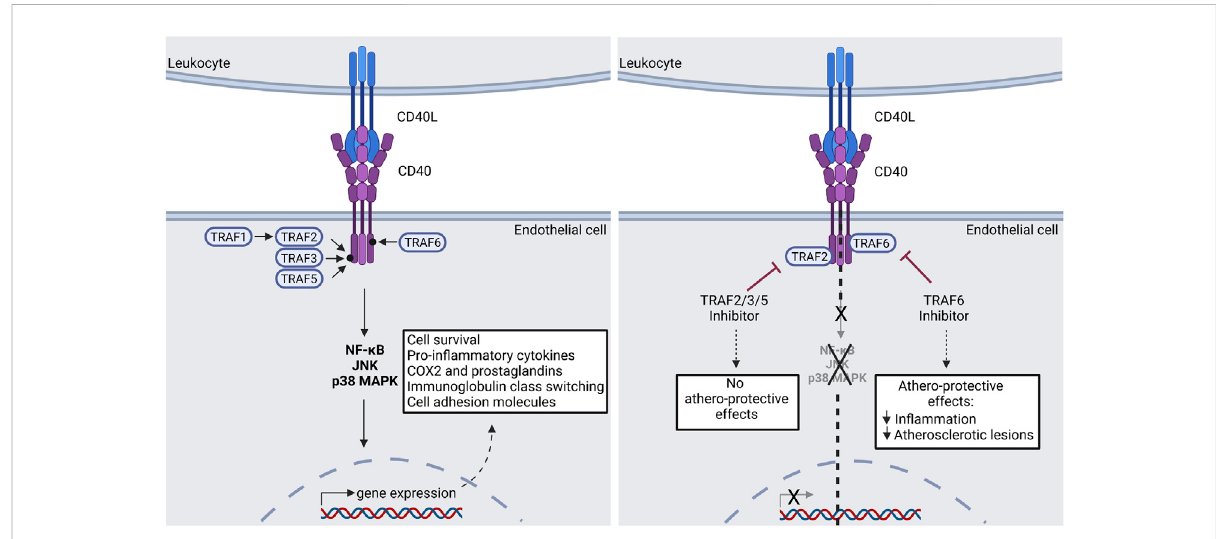
FIGURE 4 CD40(L)signaltransduction via TRAFmolecules.Down-streameffectsoftheCD40(L)dyadcanbedevidedintotwomaingroups:TheTRAF2/3/ 5-dependent effects are regarded as athero-protective, while the TRAF6-dependent effects promote atherosclerosis. A potential pharmacological approach is presented in the right panel. Consequently, selective TRAF6-inhibition could be used clinically in order to treat atherosclerosis. TRAF: Tumor Necrosis Factor Associated Factor; JNK: c-Jun N-terminal kinase; p38 MAPK: p38 mitogen-activated protein kinase; NF- κ B: Nuclear factor kappa B; COX2: Cyclooxygenase 2. Scheme was summarized from data in (Seijkens et al., 2018). Created with